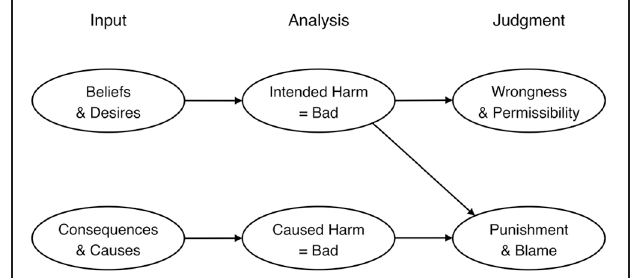
FIGURE 1 | Cushman’s causal-intentional model of moral judgment. Reprinted from Cushman (2008) with permission from